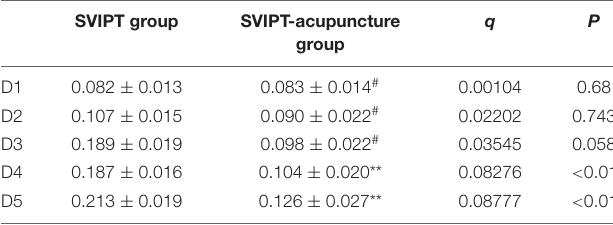
# Represents P > 0.05. **Represents P <